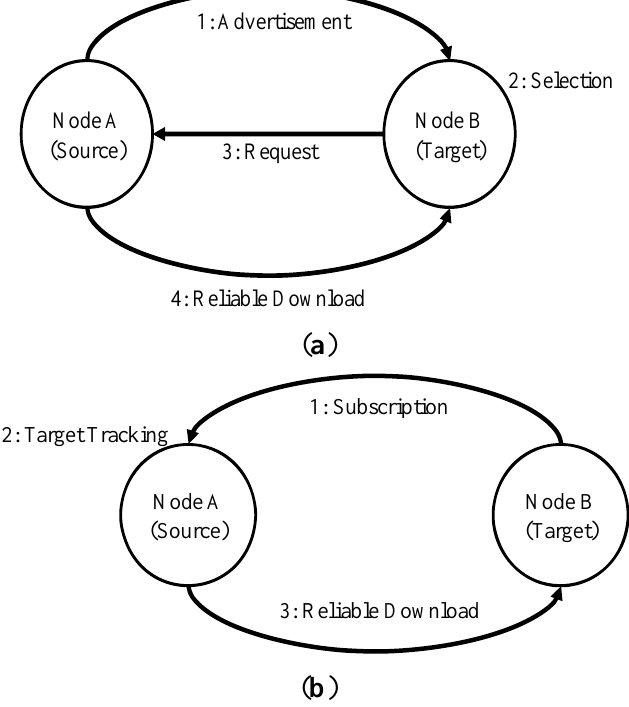
Figure 3. ( a ) Advertisement Pattern for Dissemination Protocols; ( b ) Subscription Pattern for Dissemination